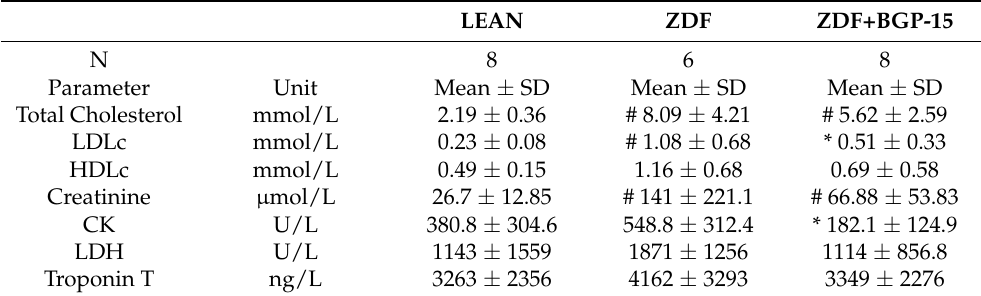
Table 2. Values of cardiac- and lipid homeostasis biomarkers.